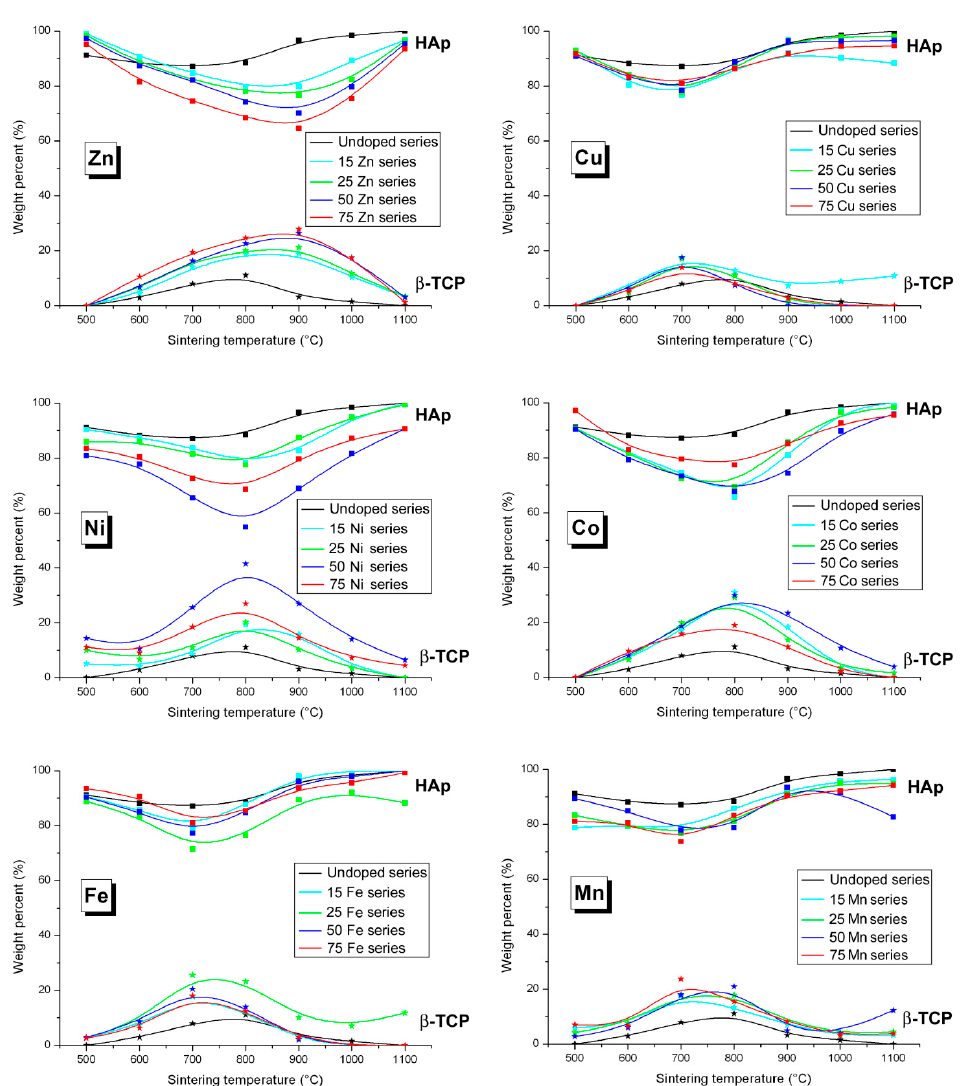
Figure 1. Weight percent of HAp (squares) and β -TCP (stars) obtained from Rietveld refinements for all the Zn-, Cu-, Ni-, Co-, Fe-, and Mn-doped samples: black lines for the undoped series, light blue lines for the 15 M -T series, green lines for the 25 M -T series, dark blue lines for the 50 M -T series, and red lines for the 75 M -T series. The lines are only visual guides.